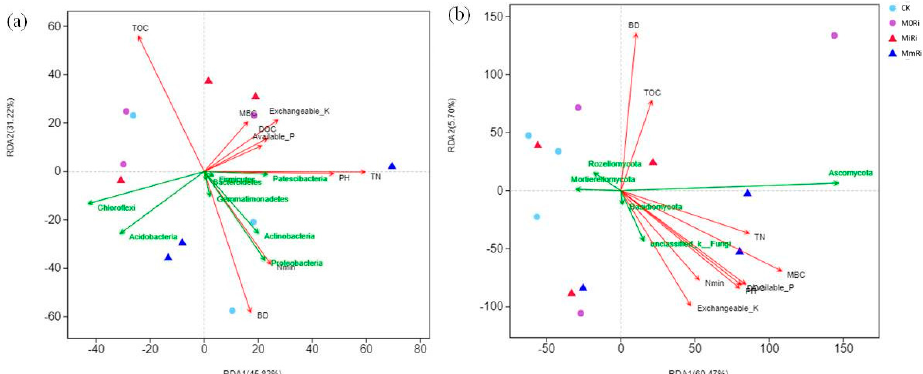
Figure 3. Redundancy analysis of ( a ) the abundant bacterial phyla and ( b ) the abundant fungal phyla orders and nine soil properties (pH, BD, TOC, TN, DOC, MBC, N min , available P, and exchangeable K) of different straw-return treatments. Note: BD, bulk density; TOC, total organic carbon; TN, total nitrogen; DOC, dissolved organic carbon; MBC, microbial biomass carbon; N min , mineralized nitrogen.